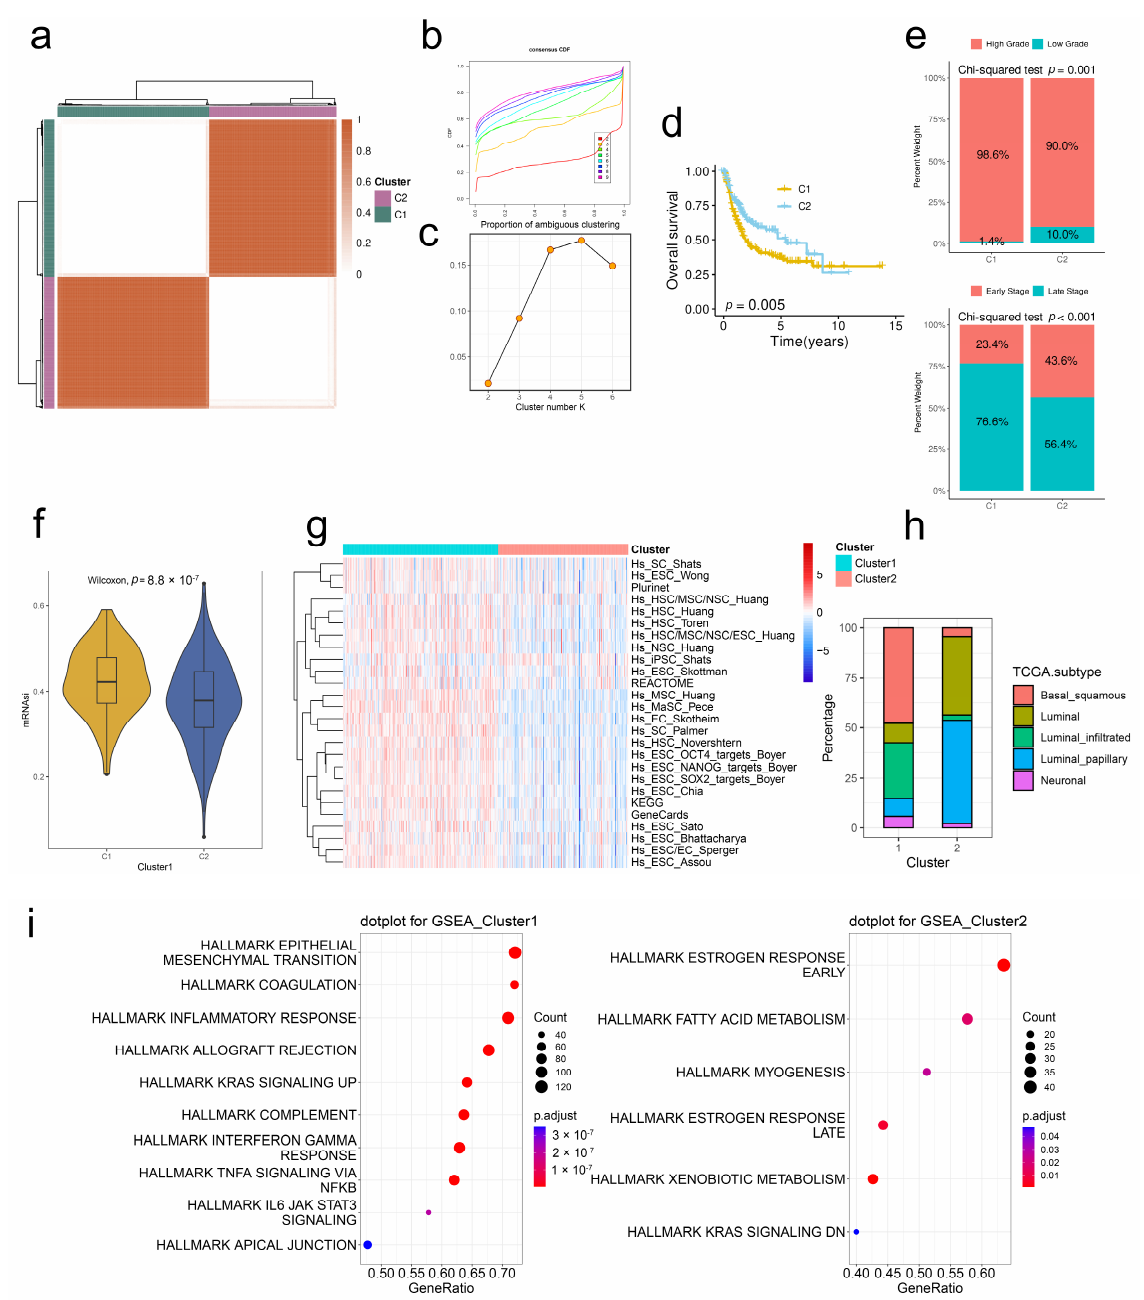
Figure 3. Stem. Sig. stratifies the TME of TCGA-BLCA into two molecular subclusters. ( a ) The consensus score matrix when k = 2. The CDF curves ( b ) and PAC scores ( c ) of the consensus matrix for each k. ( d ) KM curves with log-rank test revealed the poor prognosis of cluster 1. ( e ) Upper panel: The proportion of high- and low-grade between two clusters. Lower panel: The proportion of late- and early-stage between two clusters. Late stage, stages III and IV, early stage, stages I and II. ( f ) The distribution of mRNAsi between two clusters. ( g ) The heatmap showed the enrichment scores of 26 stemness-related signatures in two clusters. ( h ) The distribution of TCGA molecular subtypes between two clusters. ( i ) GSEA analysis demonstrated upregulated hallmark gene sets in two clusters.